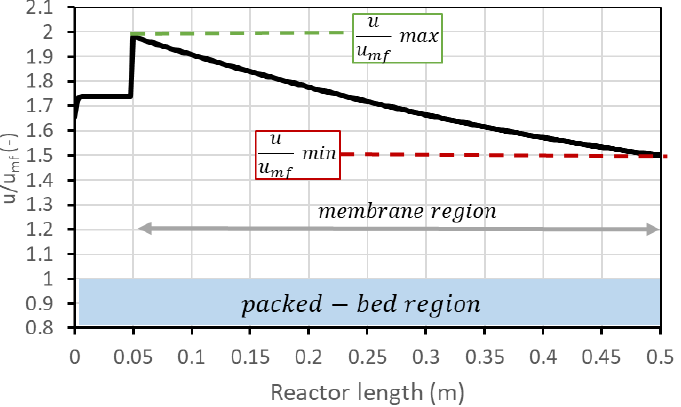
Figure 3. Trend of u / u mf along the reactor. After 5 cm from the bottom, the membrane region Figure 3. Trend of 𝑢/𝑢 𝑚𝑓 along the reactor. After 5 cm from the bottom, the membrane region starts.